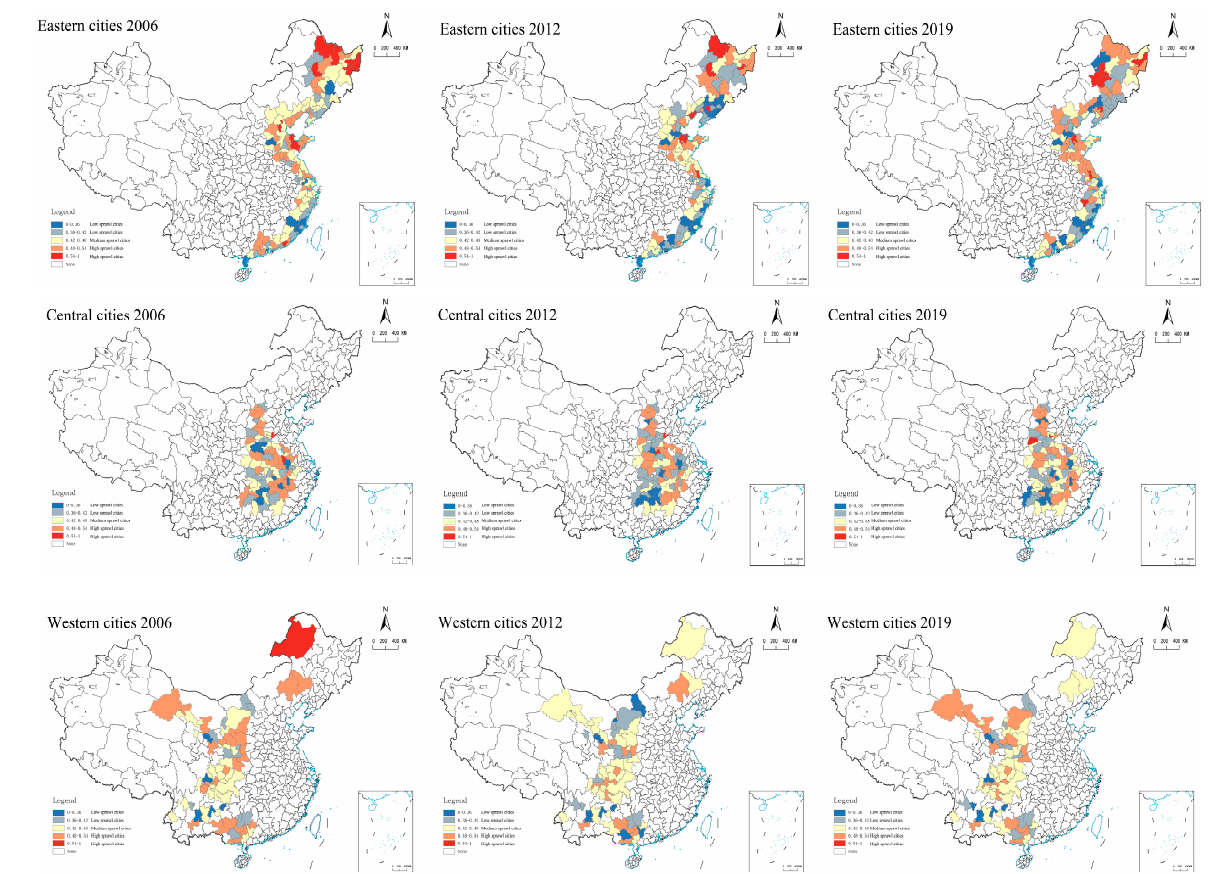
Figure 3. Spatiotemporal distribution of urban sprawl in different regions.